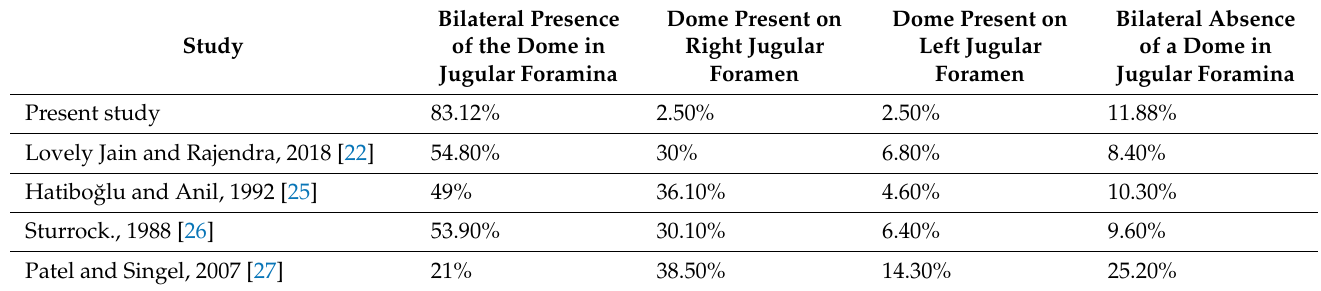
Table 6. Comparison of the dome of jugular fossa with other